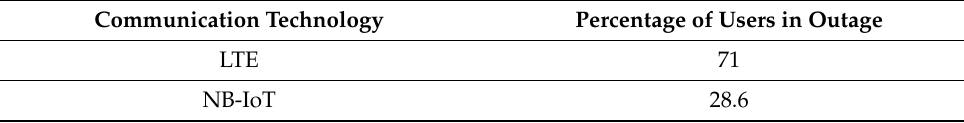
Table 3. Comparison of the number of outage users in NB-IoT and LTE (4G) technologies